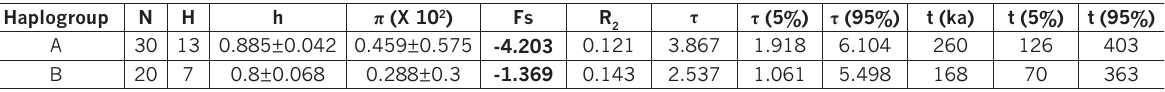
Table 2. N, number of mtDNA sequences; H, number of unique mtDNA haplotypes; h, mtDNA haplotype diversity (±SD); π, mtDNA nucleotide diversity (±SD). Tests of demographic equilibrium and mismatch analysis in mtDNA phylogeographic groups: FS, Fu’s FS statistic; R , Rozas and Ramon-Onsins’ R statistic; τ, sudden demographic expansion parameter, with 5% and 95% 2 2 confidence limits; t , true time since population expansion, from τ = 2 μ T (where μ is the substitution rate per gene). Significantly small values of F and R are in S 2